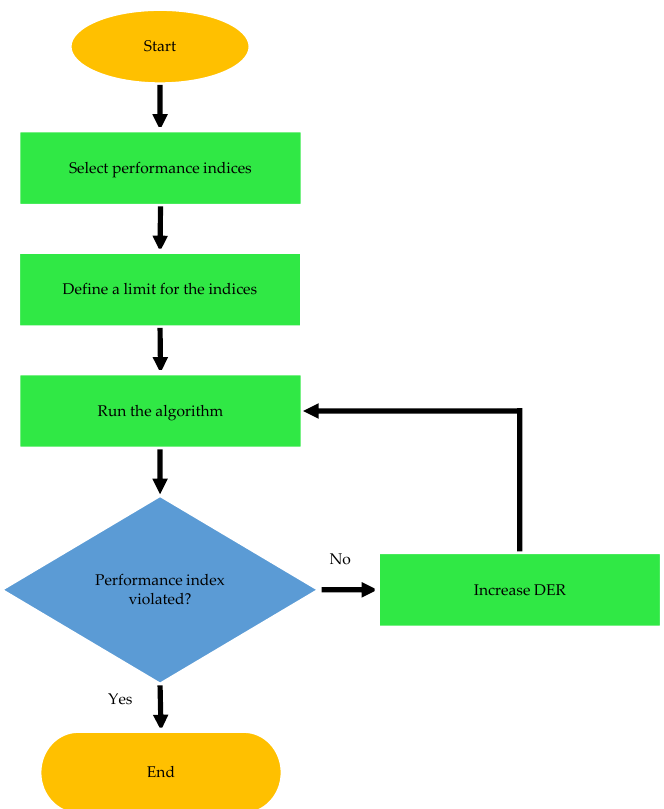
Figure 3. General HC calculation methodology.